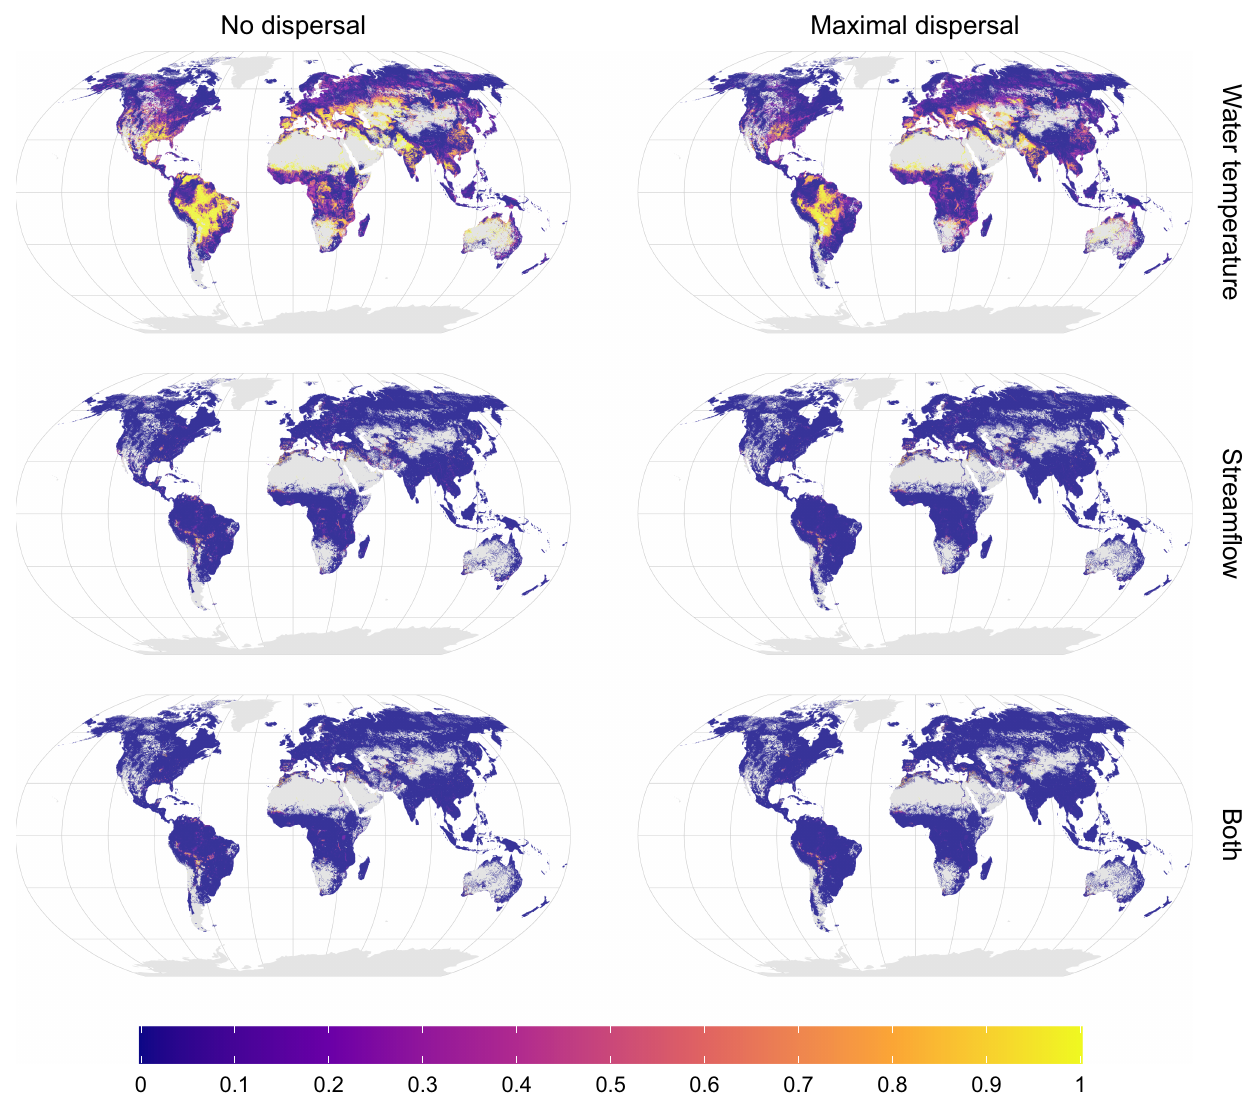
Fig. 4 Climate change threats due to water temperature versus fl ow. Potentially affected fraction (PAF) of species due to changes in water temperature (top), fl ow conditions (center), or both (i.e., fraction of species threatened by water temperature and fl ow extremes simultaneously; bottom) for the 3.2 °C warming scenario. The maps represent the median proportion of species affected over the GCM – RCP combinations available for the 3.2 °C warming scenario. Results for the other warming levels are available in Supplementary Fig. 2. A further breakdown of PAF by single variable for the 3.2 °C warming scenario is available in Supplementary Fig. 3. Gray denotes no data areas (no species occurring or no data available). Source data are provided as Supplementary Data 2 and